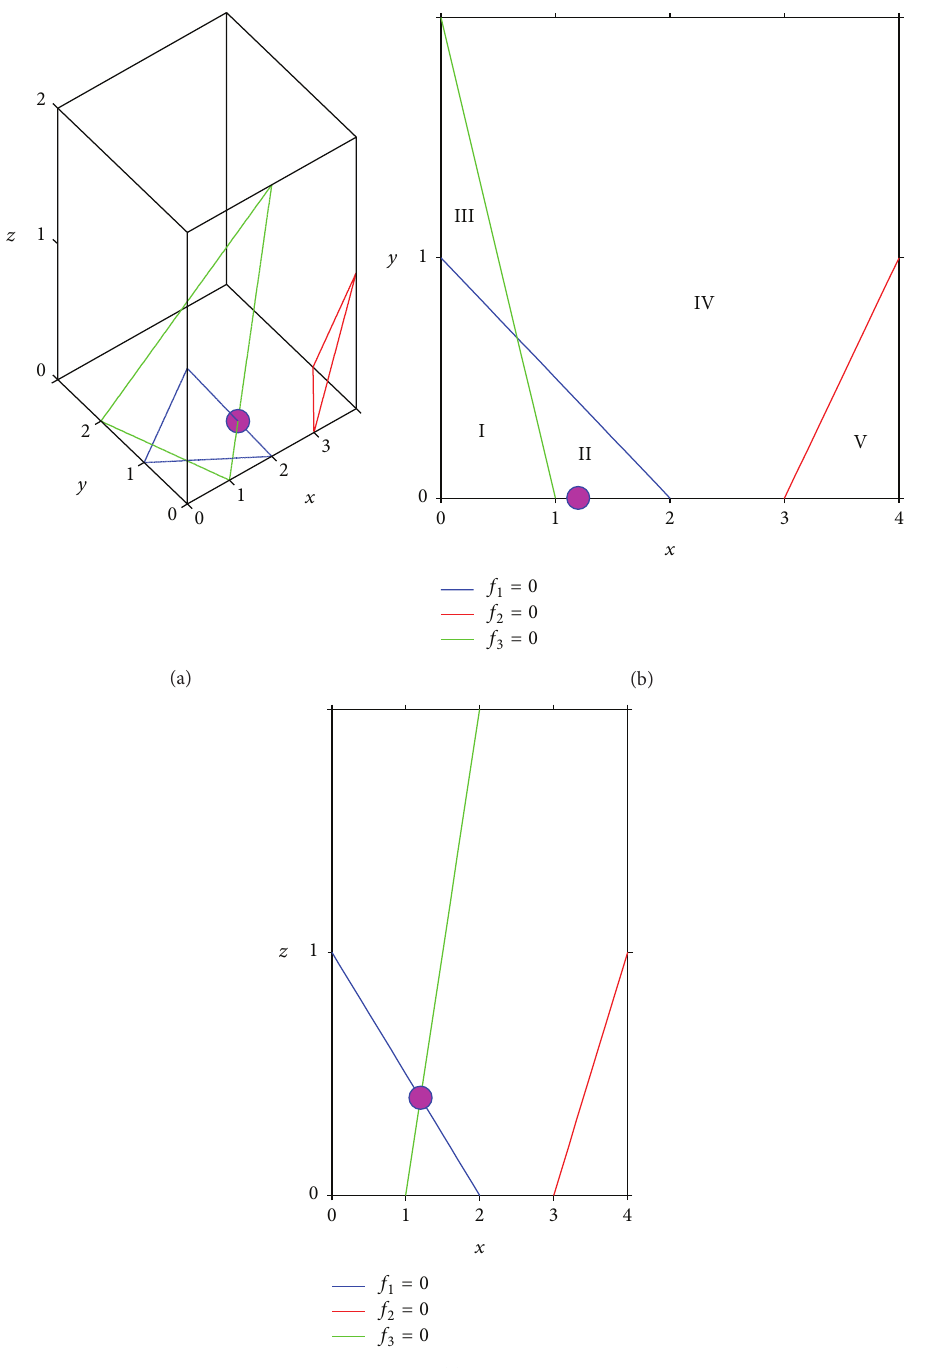
Figure 1: Three planes and regions with the globally stable point. (a) The three planes 𝑓 𝑖 (𝑥,𝑦,𝑧) = 0 ( 1 ≤ 𝑖 ≤ 3 ) in ( 0 , 4 ) × ( 0 , 3 ) × ( 0 , 2 ) . The magenta circle denotes the globally stable point ( 6 / 5 , 0 , 2 / 5 ) of scheme (7). (b) Five regions projected on the 𝑥𝑦 -plane. (c) Five regions projected on the 𝑥𝑧